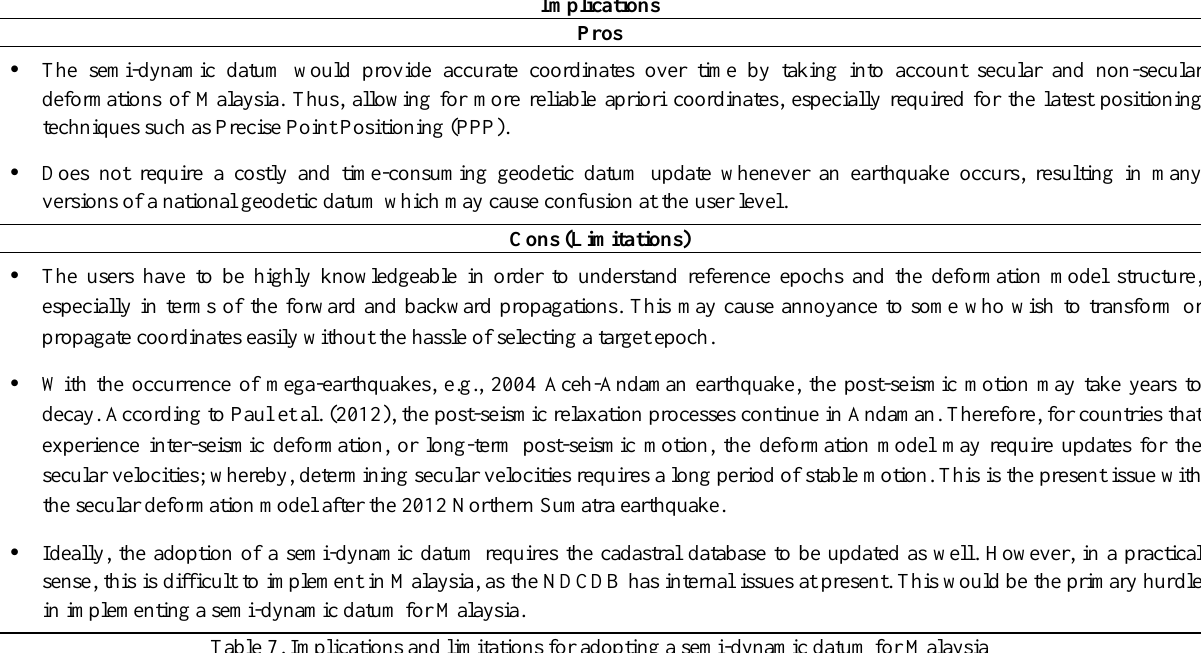
Table 7. Implications and limitations for adopting a semi-dynamic datum for